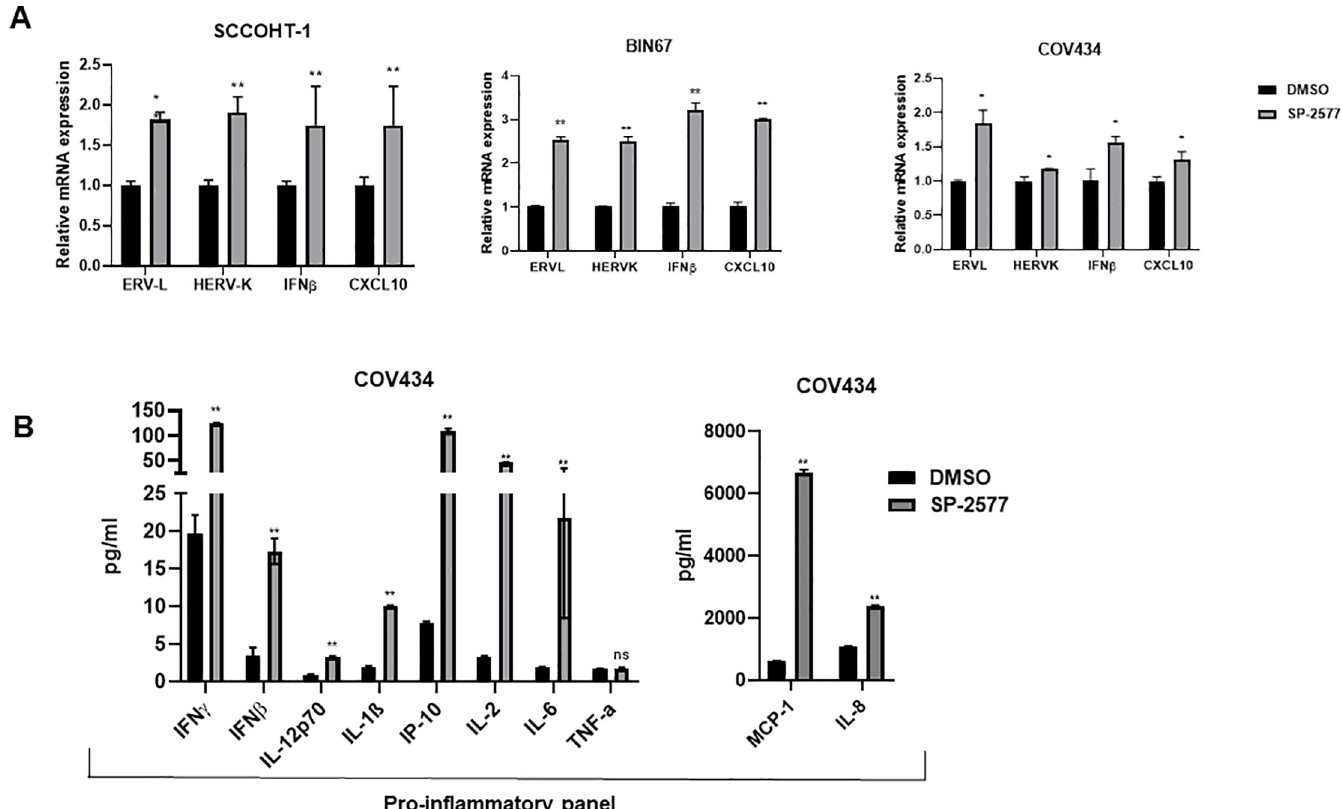
Fig 2. SP-2577 promotes ERVs expression and activation of IFN β pathway in SCCOHT cell lines. ( A ) qPCR analysis of SCCOHT cell lines SCCOHT-1, BIN67, and COV434 after 72 h of SP-2577 treatment showing increased expression of ERVs and IFN pathway cytokines. ( B ) MSD panel of chemokines and cytokines from SCCOHT COV434 cell conditioned media in the presence or absence of SP-2577 for 72 h. � = p < 0.05, �� = p < 0.01.